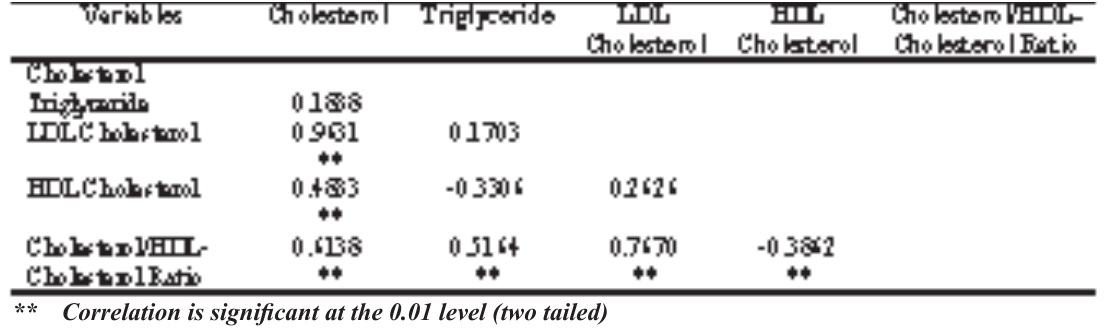
Table I: Correlation – coefficients among the variables